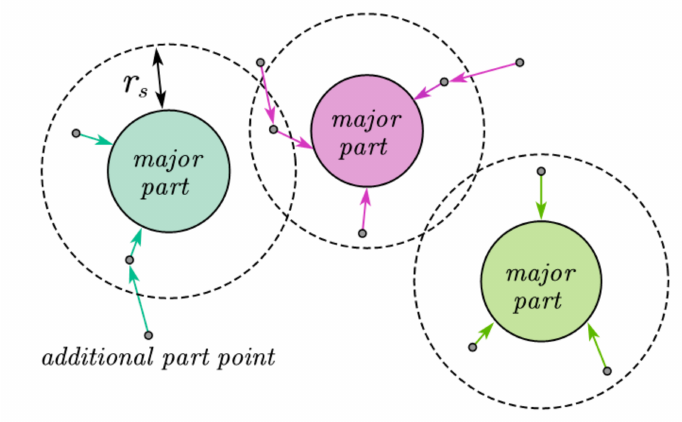
Figure 10. The schematic diagram points to the growing points of additional